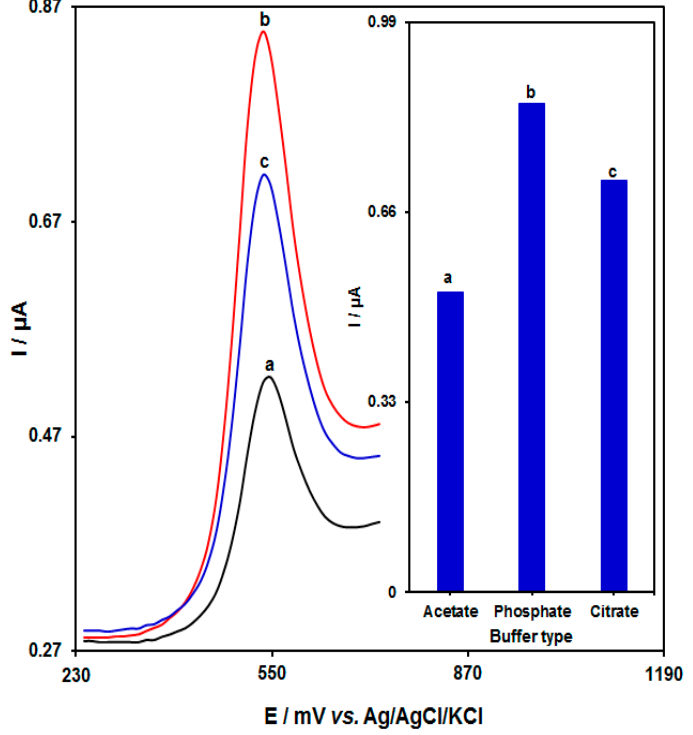
Figure 4. DPVs captured from AP/Au-NS/CPE with an aptamer concentration of 4.5 μ M, interac- tion time of the aptemer with homocysteine of 65 min and various buffers. a–c: (a) acetate, (b) phosphate, and (c) citrate, sequentially. Inset: a plot of peak current versus various buffers.